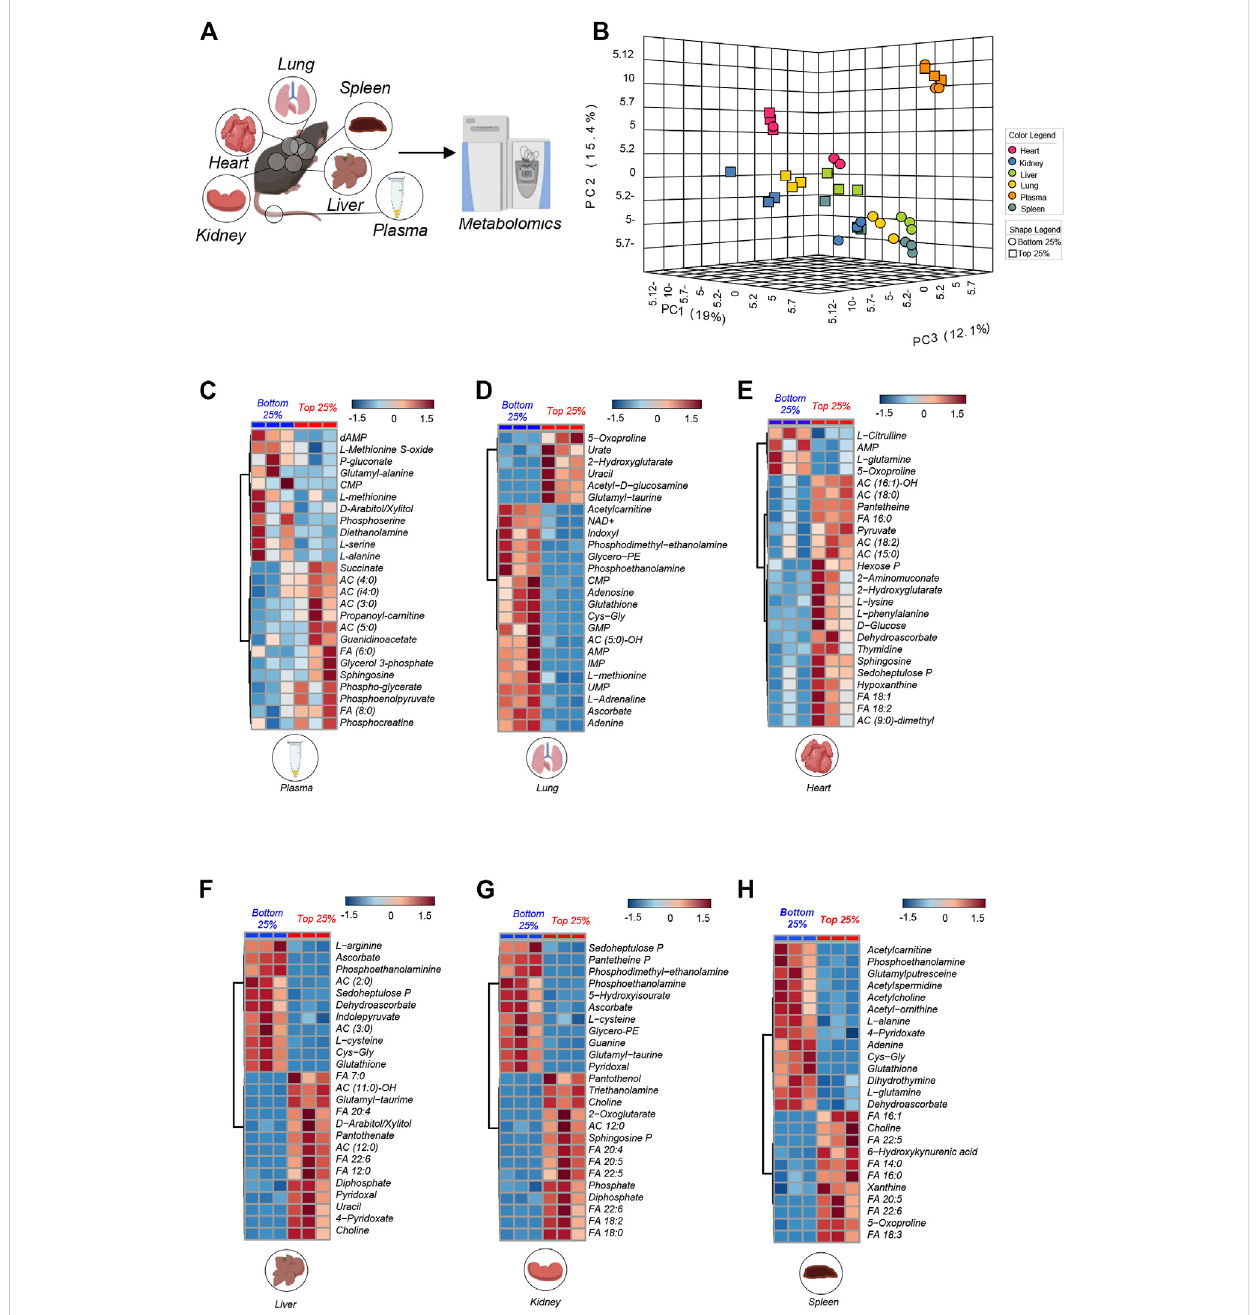
Metabolic overview highlights difference in matrixes. In (A) All matrix (plasma, spleen, liver, lung, heart, kidney) run on mass spectrometry for metabolite analysis from the top 25% ( n = 3) and bottom 25% ( n = 3) mice. In (B) PCA analysis of all matrixes analyzed in Top 25% ( n = 3) and Bottom 25% ( n =3).In (C – H) :Hierarchicalclusteringofthetop25ANOVAsigni fi cantmetabolitesacrossmultipleorgans,asspeci fi